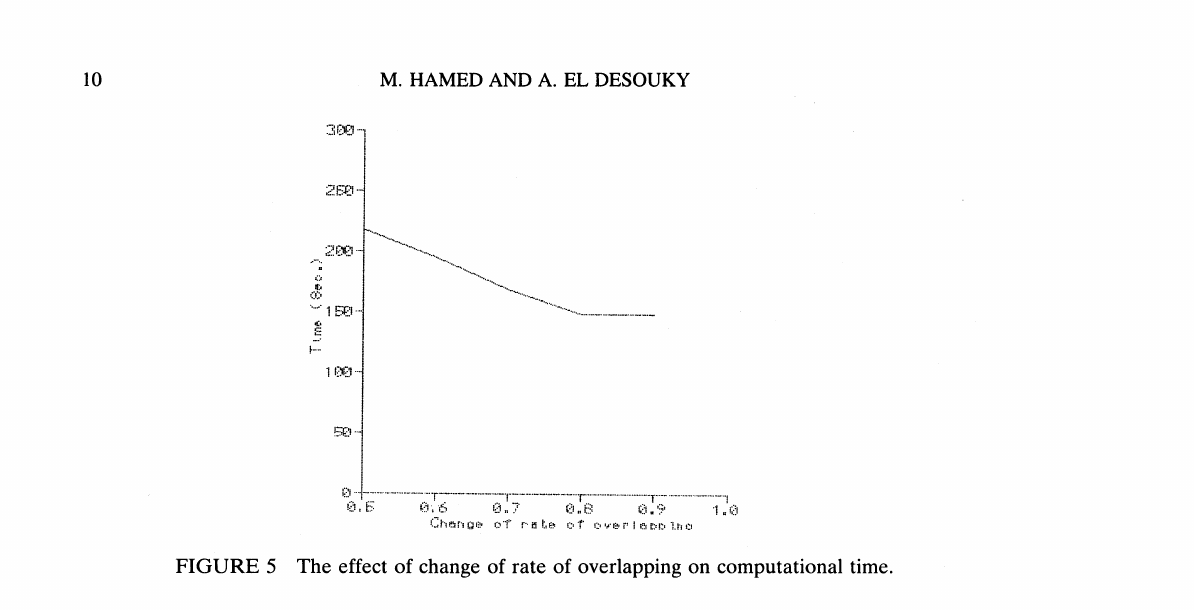
FIGURE 5 The effect of change of rate of overlapping on computational time.